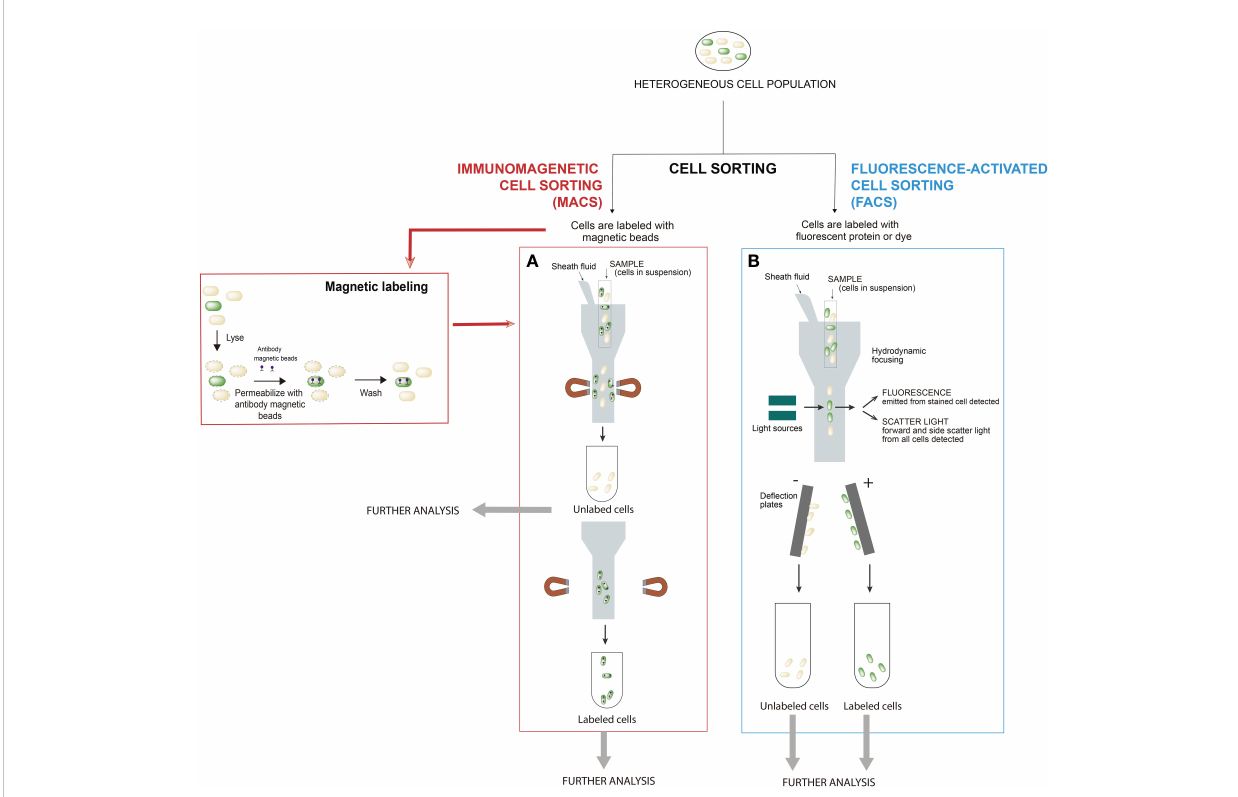
FIGURE 1 Most common cell sorting techniques for screening microbial populations: (A) Immunomagnetic cell sorting (MACS) and (B) Fluorescence-activated cell sorting (FACS). In the procedures for bacterial cell handling during separation by cell sorting, cells are treated according to the respective protocols related to the type of cell sorting to be performed. In MACS, cells are magnetically labeled with microbeads and FACS requires that cells are stained with either a dye(s) or fl uorescent protein(s). In MACS, fi rstly, labeled cells with magnetic beads are retained in the system, while unlabeled cells pass through (negative cell fraction). Secondly, the magnet is removed from the sample and the target magnetic-bead-labeled cells are eluted as the enriched, positively selected cell fraction. In FACS, positive and negative cells for fl uorescence are separated simultaneously. Modi fi ed from (Ferna ́ ndez-Ferna ́ ndez et al.,